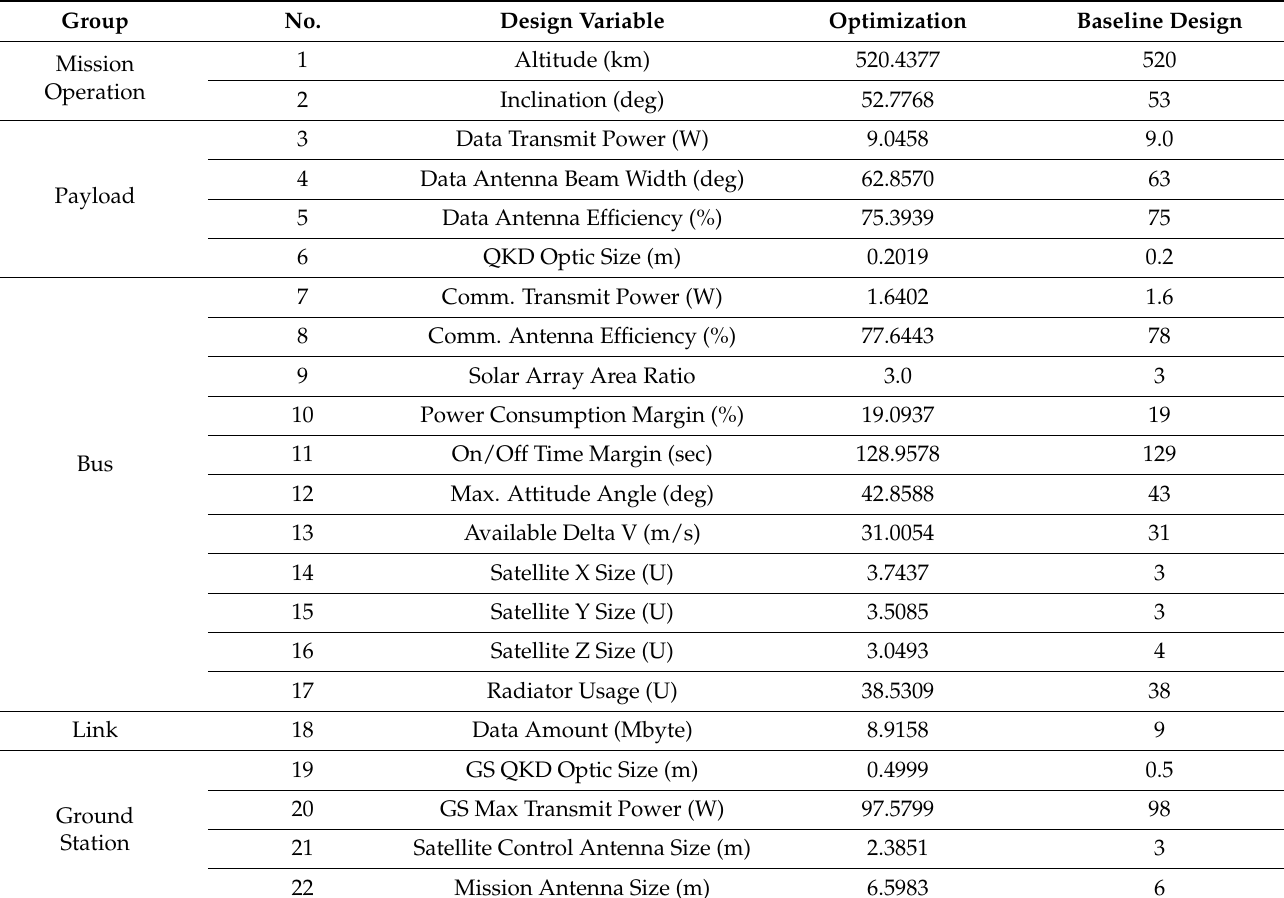
Table 11. Design variable values of the final baseline